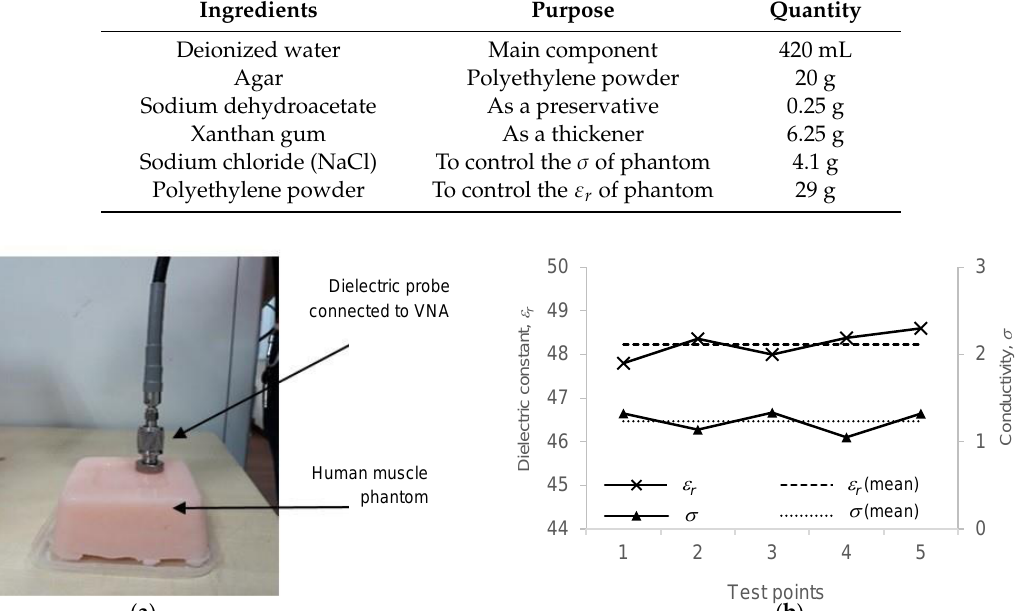
Figure 9. Measurement setup for return loss ( S 11 ): ( a ) In free space (Case A); ( b ) In the presence of the muscle phantom (Case B).